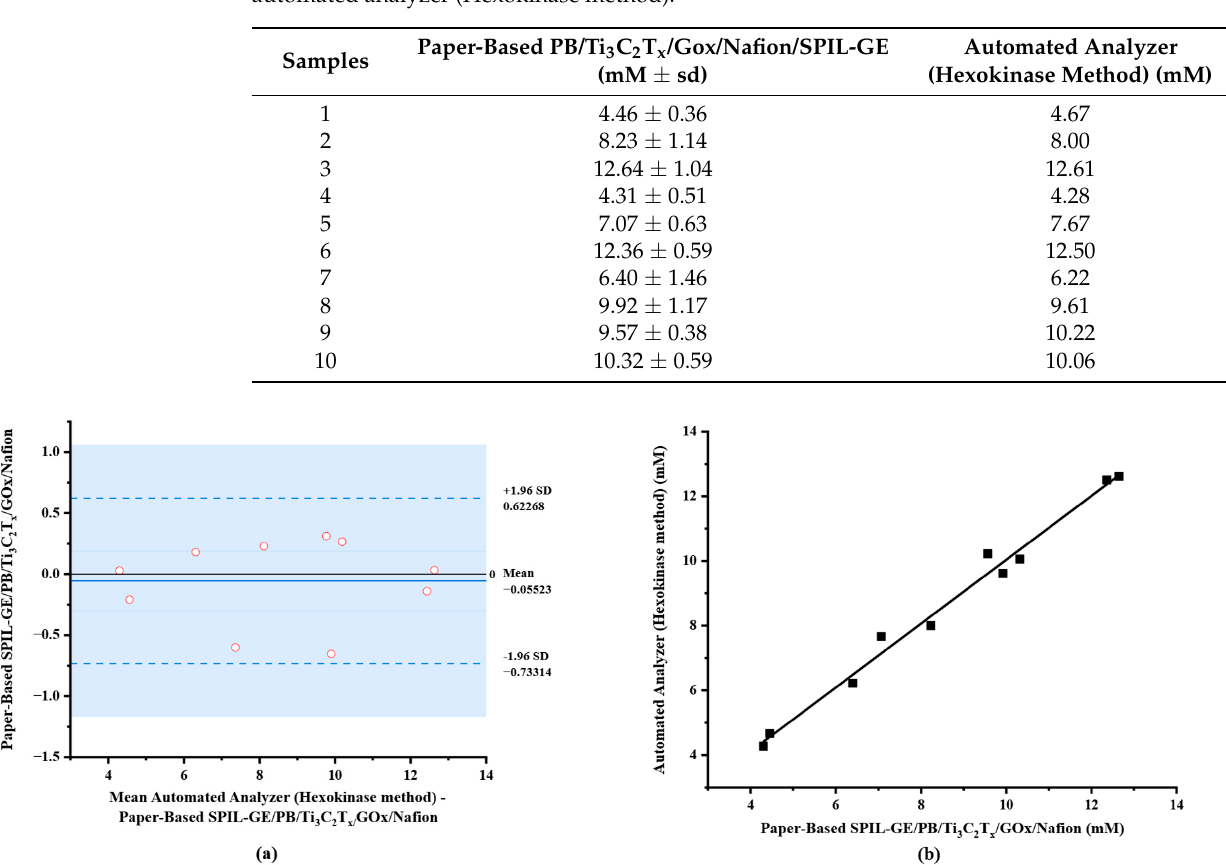
Table 1. Result of glucose detection in blood plasma samples based on electrochemical method and automated analyzer (Hexokinase method).